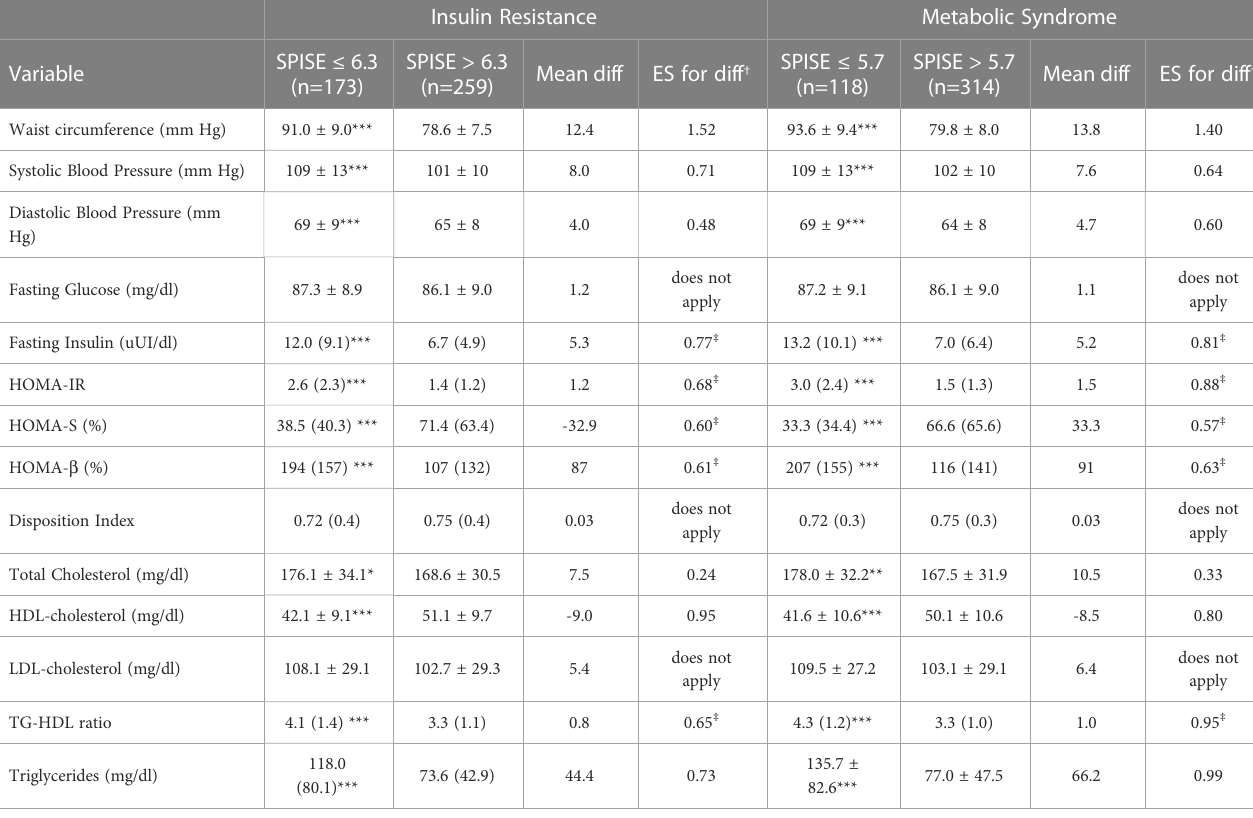
TABLE 4 Cardiometabolic pro fi le in prepubertal obese patients according to optimal cutoff values of SPISE to predict IR (6.3) and MetS (5.7).